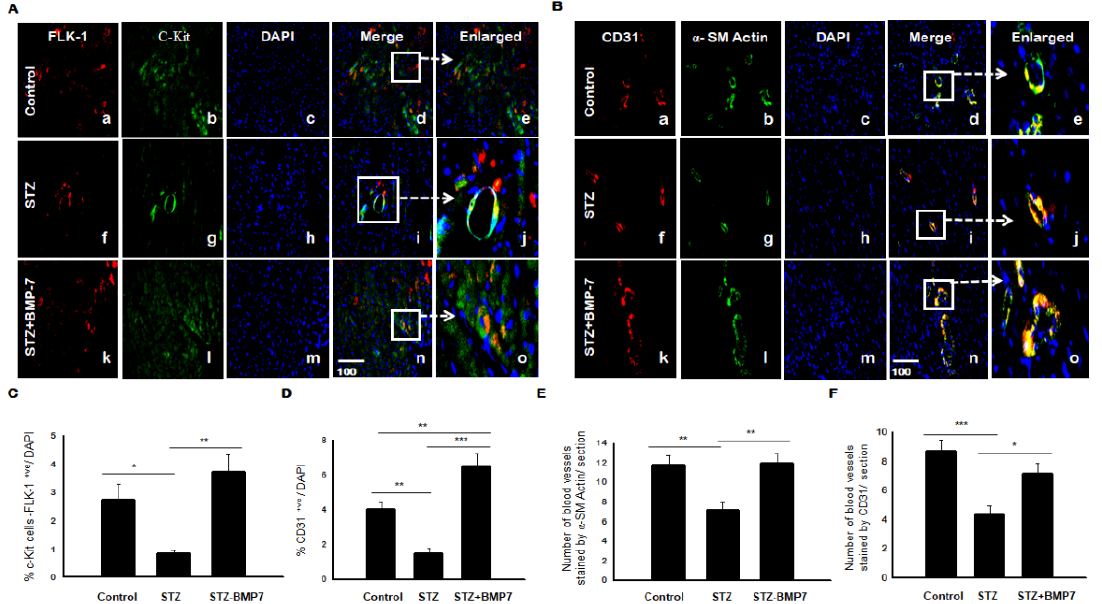
Figure 7. BMP-7 enhances the recruitment of c-kit, Flk-1, and CD31 cells with neovascularization in diabetic cardiac tissues. ( A , B ) Representative photomicrographs of heart sections stained in the control group (a–e), STZ group (f–j), and STZ-BMP7 group (k–o) with c-Kit ( A ) and α -SM actin ( B ) in green (b, g, l) and FLK-1 ( A ) and CD31 ( B ) in red (a, f, k) with nuclei stained (c, h, m) by DAPI in blue, merged (d, i, n) and enlarged (e, j, o) image. ( C , D ) Quantitative analysis of c-Kit/ Flk-1 ( C ) and CD31 ( D ) +ve cells (colocalization of both red and blue DAPI in cardiomyocyte) quantified over total DAPI in heart sections of mice. ( E , F ) The number of blood vessels stained with α -SM actin (green, E ) and endothelial lining blood vessels CD31 (red, F ) are counted in heart sections of mice. Statistical analysis was performed using One-Way ANOVA, which was followed by the Tukey test. Error bars= mean ± S.E.M. * p < 0.05, ** p < 0.01, *** p < 0.001; Scale bar = 100 µm; n = 16/group.